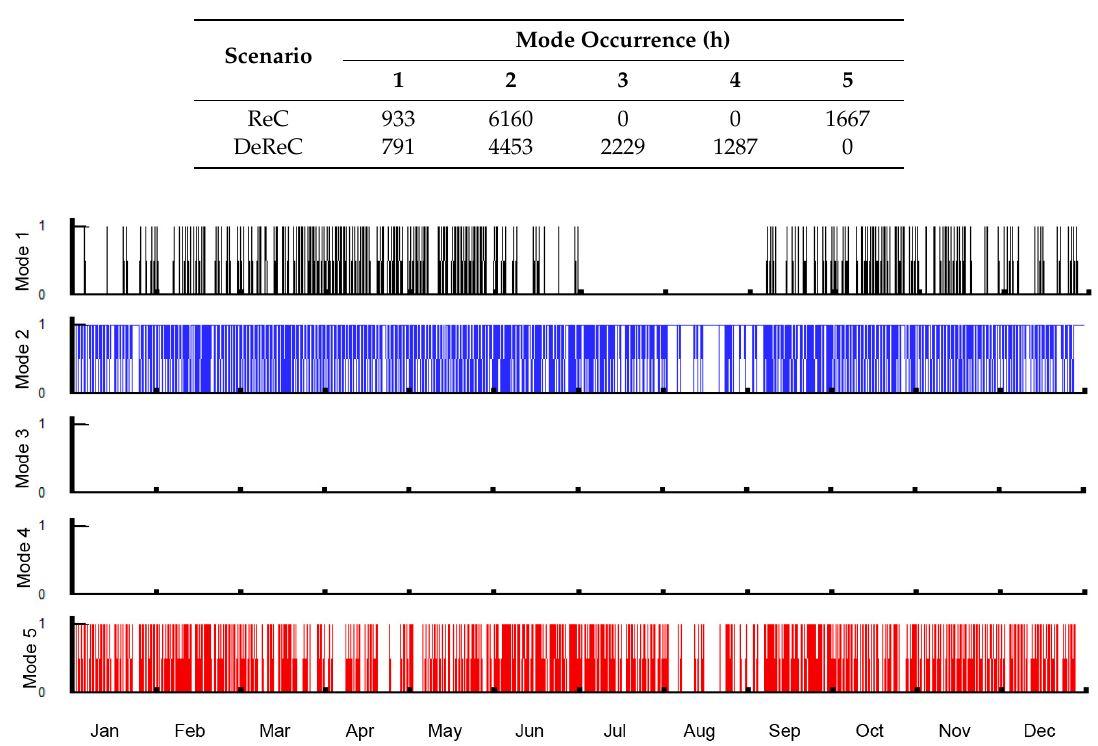
Figure 4. Operating modes occurrence of the ReC system during a reference year